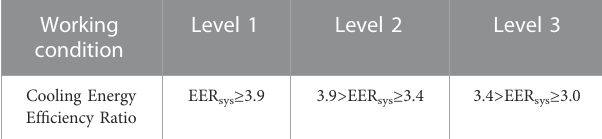
TABLE 6 Performance level division of GWHP